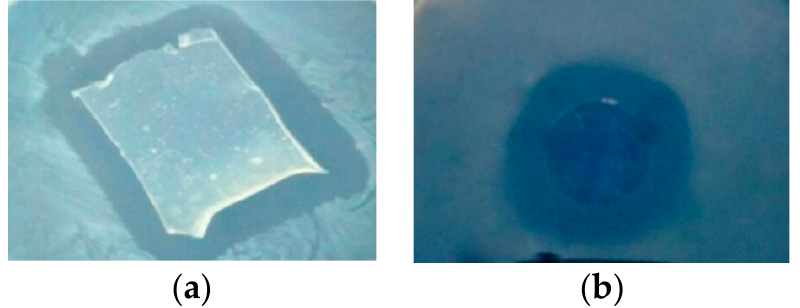
Figure 1. Example of anti- Listeria activity, detected by agar diffusion assay. After incubation at room temperature for 24 h, the antagonistic activity was quantified by a clear zone of inhibition in the indicator lawn around both active film ( a ) and coating ( b ).